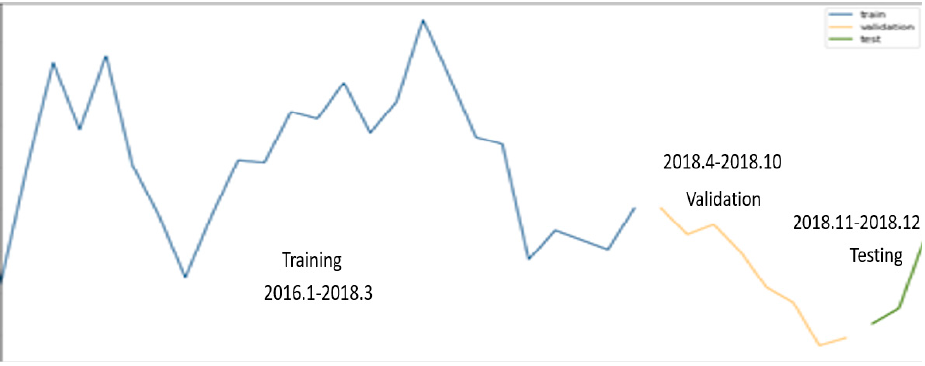
Figure 7. Visualization of epidemic of hepatitis A dataset (training, validation, test data).